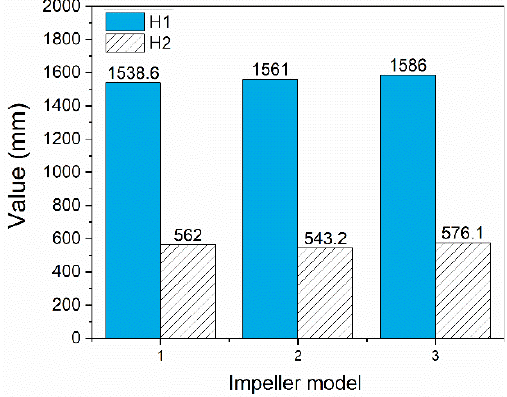
Figure 4. The turbulence intensity of the molten iron. ( a ) impeller model 1, ( b ) impeller model 2, ( c ) impeller model 3.